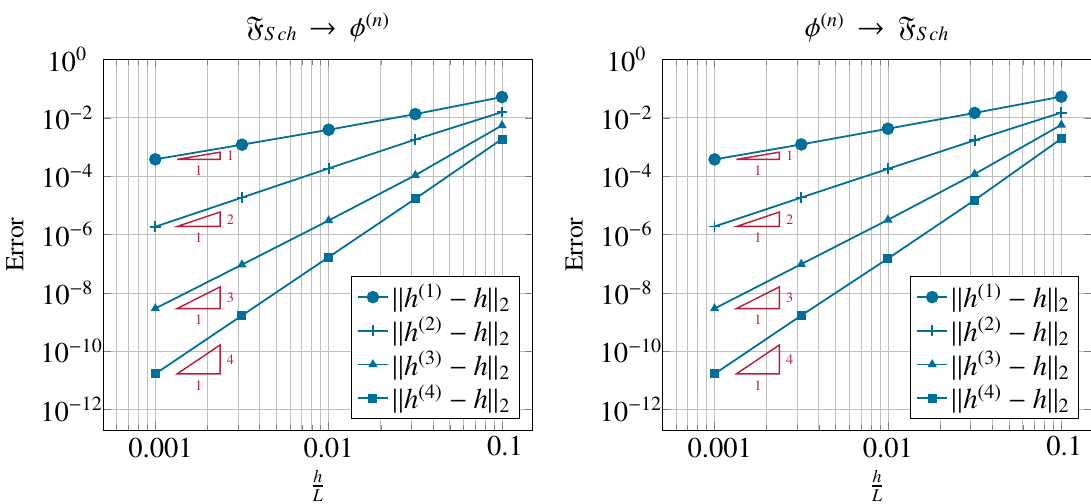
Figure 5. Schwarz P convergence study. In both panels, the error in the measured offset h m is plotted against different predefined normalized offsets. In the left figure, the offsets were measured starting from points on F Sch ( (cid:126) x ) = 0 to points on each surface φ ( n ) ( (cid:126) x , h ) = 0, respectively. In the right figure, the measurement direction is reversed. The triangles represent the corresponding slope for each order n .